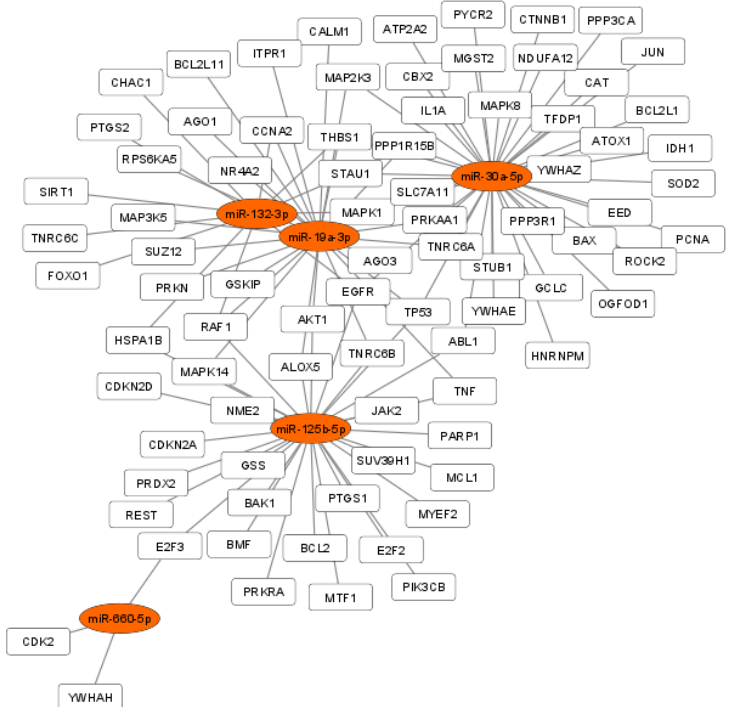
Figure 4. DE miRNA target genes related to the cellular response to oxidative stress. Regulatory network showing the interaction between miR-125b-5p, miR-132-3p, miR-19a-3p, miR-30a-5p and miR-660-5p and their validated mRNA targets. Orange ellipses represent miRNAs and white rectan- gles represent mRNA target genes involved in the cellular response to oxidative